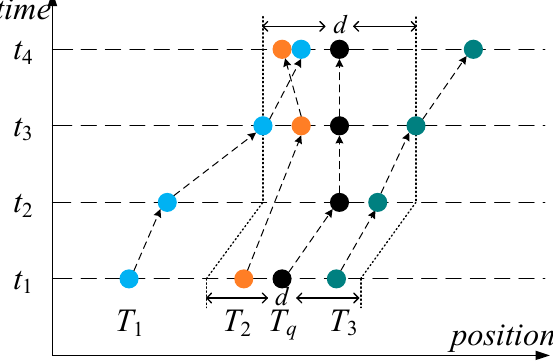
Figure 1. Example of threshold-based historical continuous (THC) query.